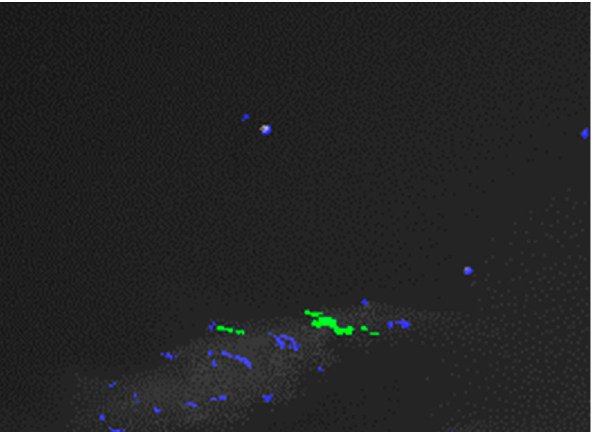
Figure 10. False streaks caused by clouds. The green areas are possible streaks, while the blue areas show movement but they are rejected by the shape criteria.